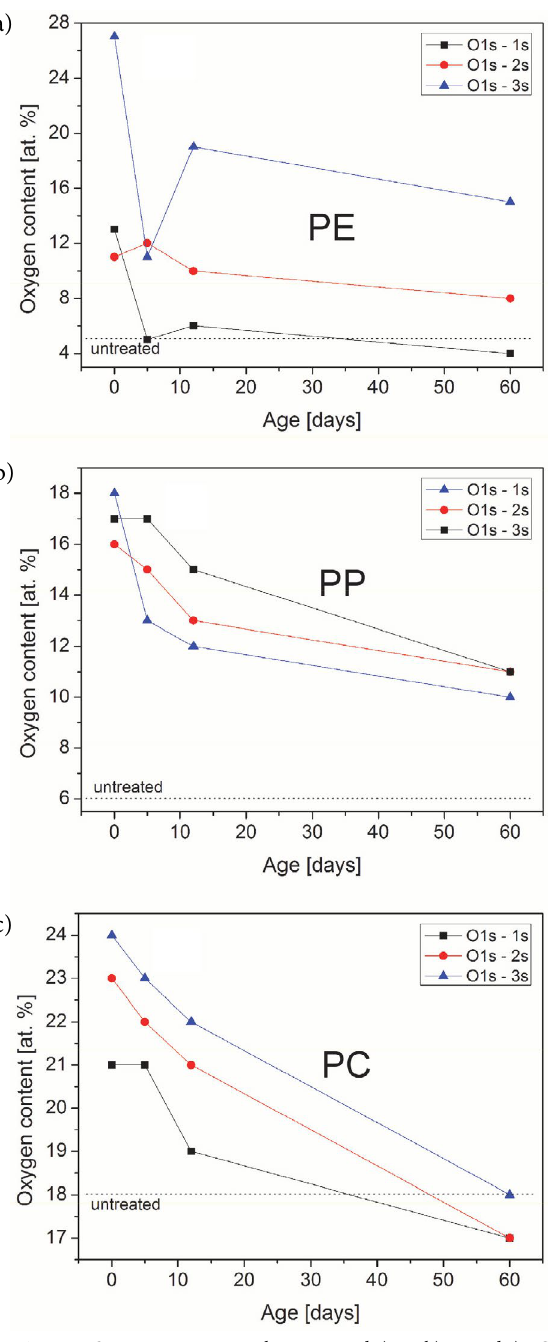
Figure 5 . Root mean square roughness calculated from AFM imag- es of untreated (filled squares) and plasma treated samples (circles). 10 µm scan size is